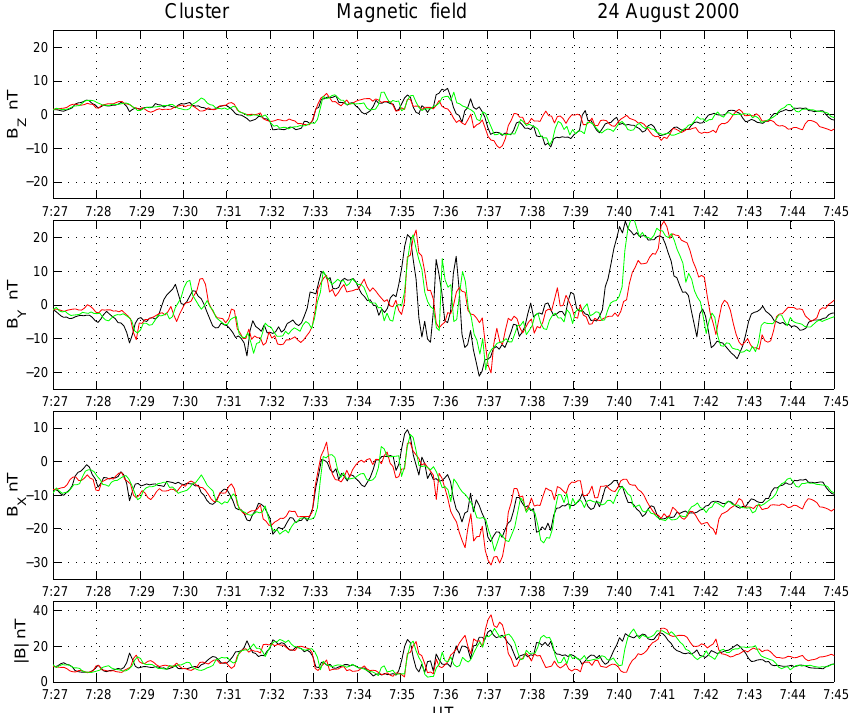
Fig. 5. De-trended magnetic field components and field magnitude between 07:27 and 07:45UT on 24 August 2000. The de-trending was done by calculating 2 min averages of the background field, and then subtracting this from the total